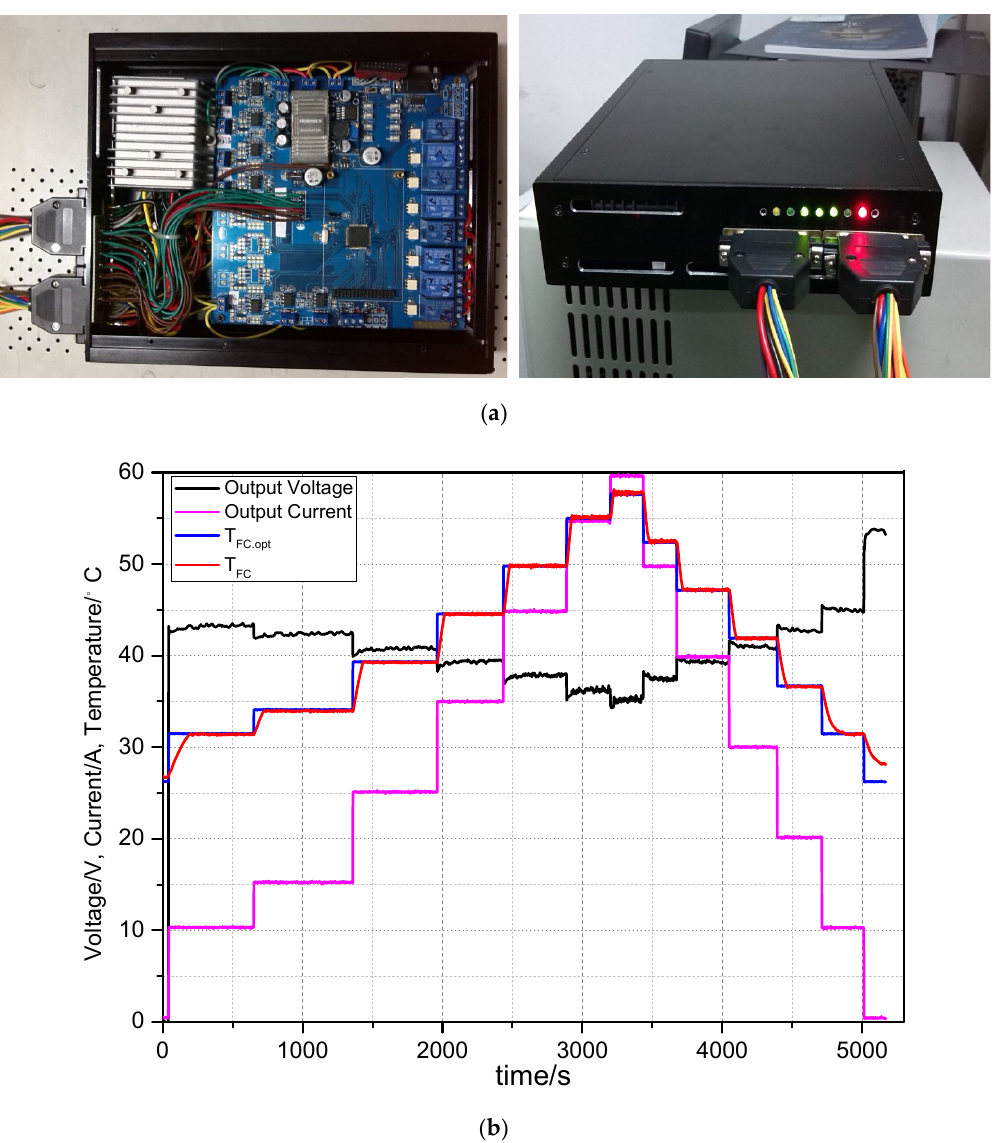
Figure 6. PEMFC controller. ( a ) Prototype of the PEMFC controller; ( b ) Response curve of control.